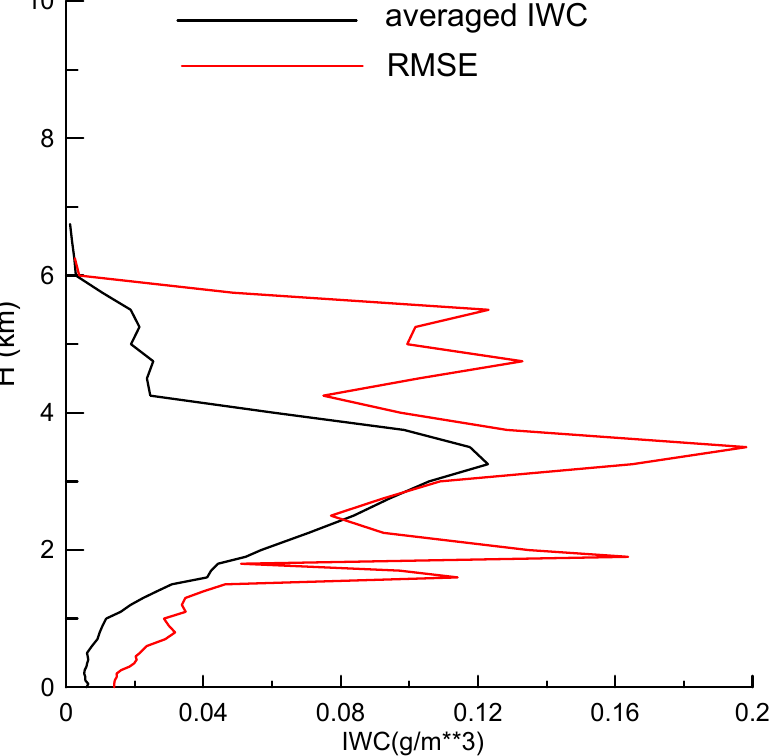
Figure 7. Averaged ice water content (IWC) and its root-mean-square error (RMSE) profiles obtained by the microwave radiometer.